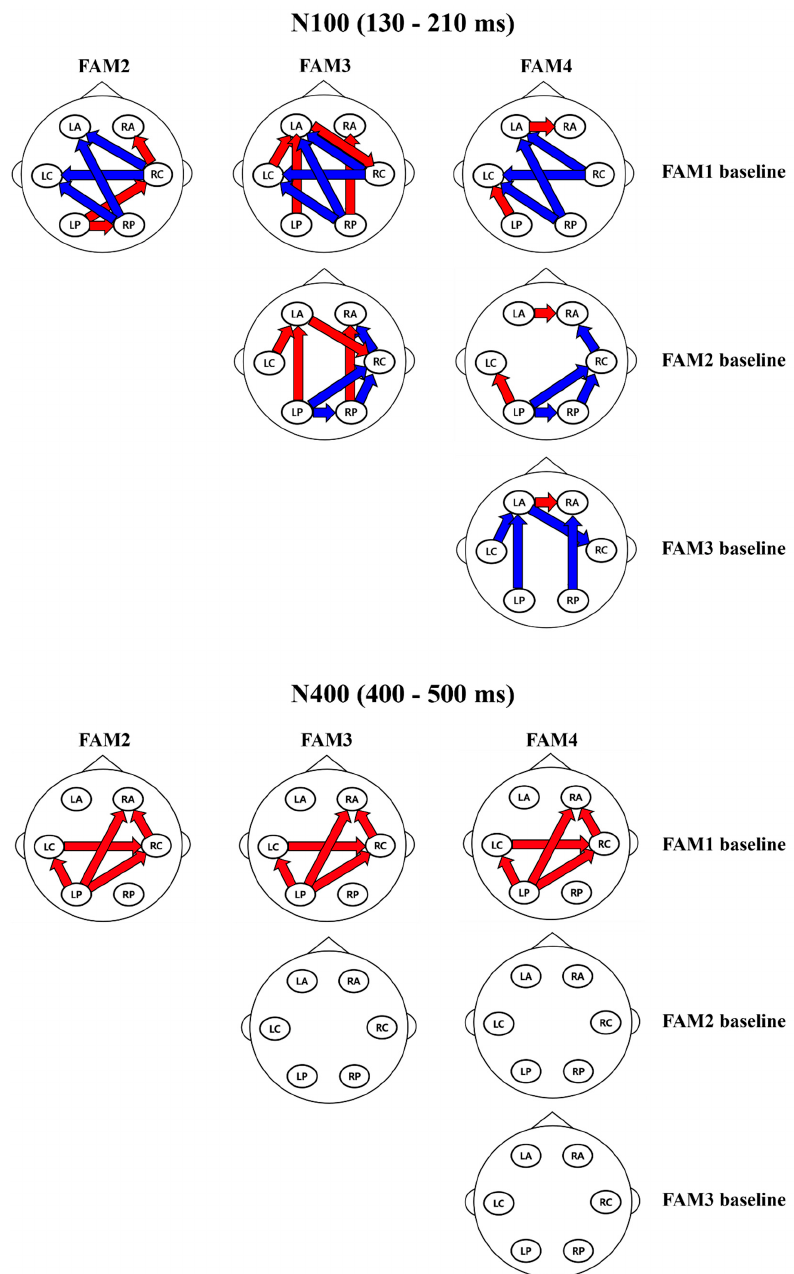
Figure 2. The patterns of the Granger causality between electrode regions on the scalp over N100 (130 − 210 ms) and N400 (400 − 500 ms) after the word presentation. This presents the Granger causality in each familiarity level compared to the baselines (FAM1, FAM2, and FAM3). The blue arrows indicate the newly significant Granger causality in the corresponding familiarity level compared to the baselines, while the red arrows denote the Granger causality that changed to insignificant relative to the baselines. Abbreviations: LA (left anterior), LC (left central), LP (left posterior), RA (right anterior), RC (right central), RP (right posterior), FAM1 (most unfamiliar), FAM2 (slight unfamiliar), FAM3 (slight familiar), and FAM4 (most